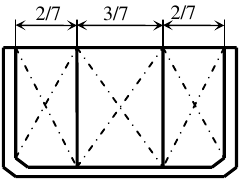
Fig 2. Typical cargo tank arrangement for tankers with cargo tanks arranged in three longitudinal lines [13]